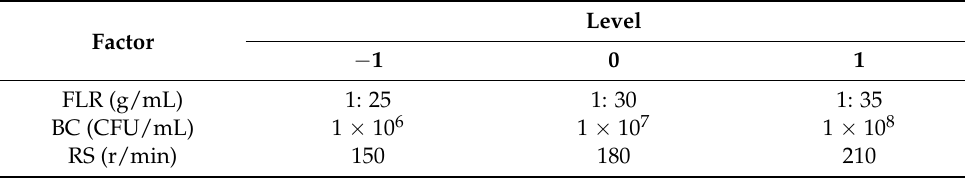
Table 2. Box–Behnken test design factor level and